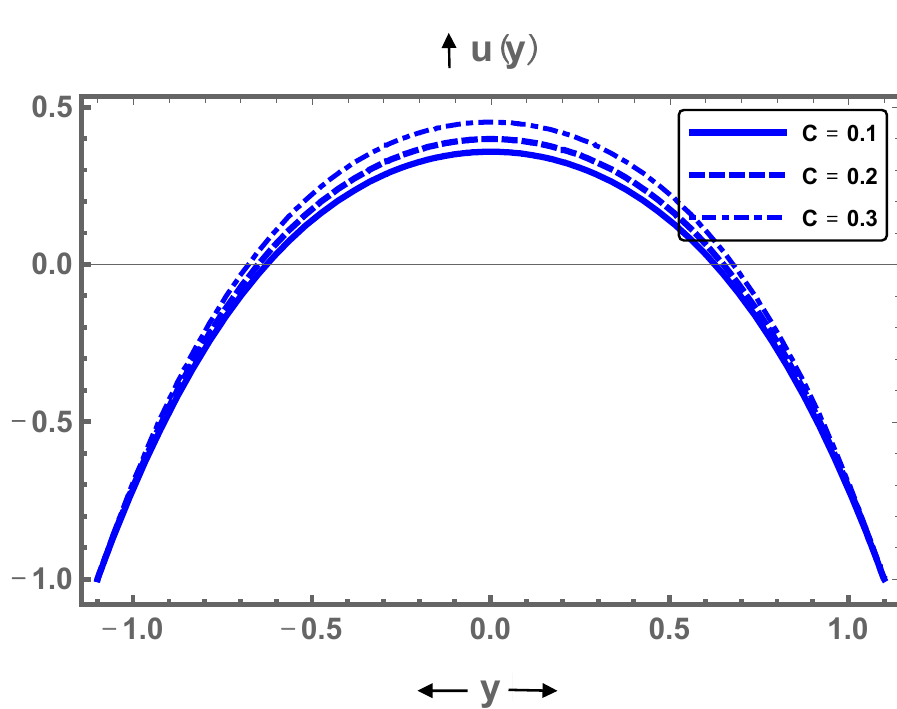
Figure 13. Display of axial velocity for different values of C .